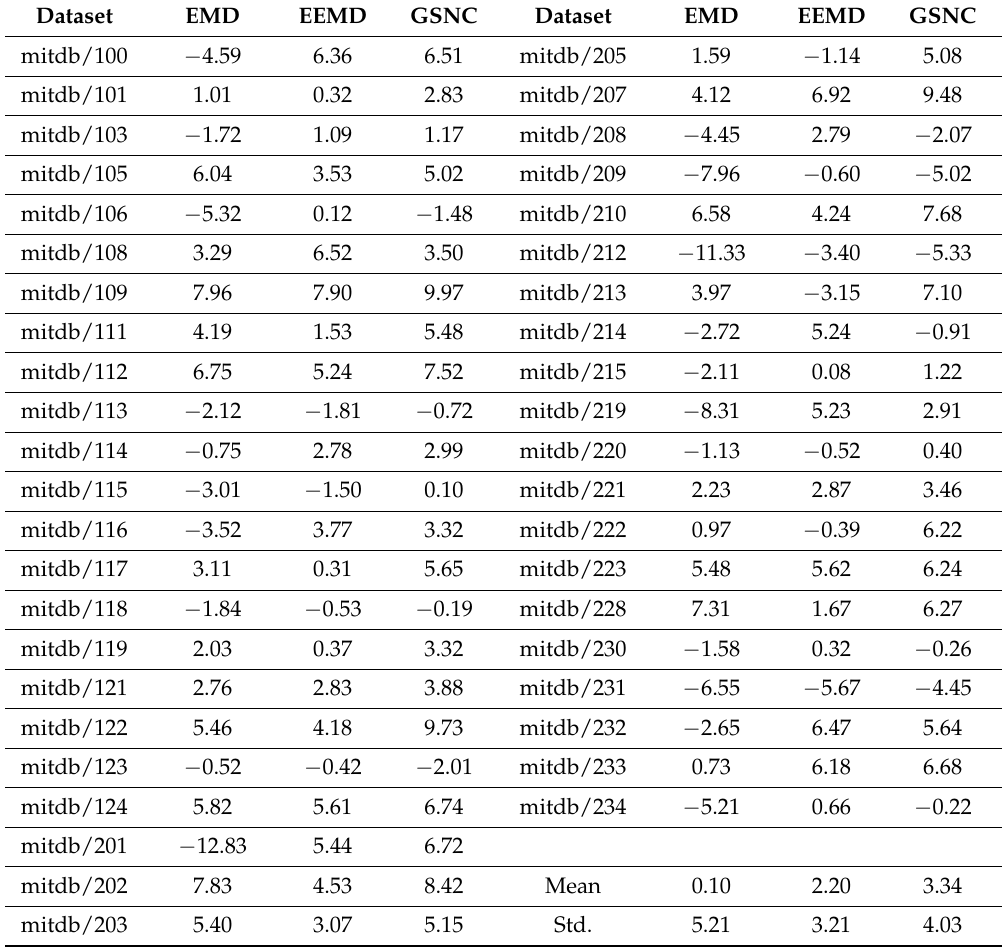
Table 3. The NER dB for the proposed GSNC and the compared schemes with the PLn ( SNR = 5 dB )